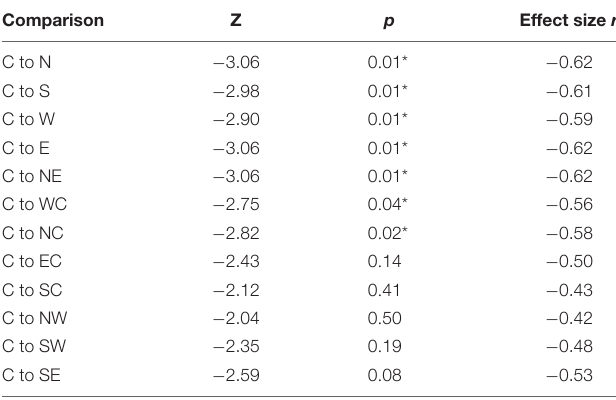
TABLE 2 | Two-tailed Wilcoxon signed rank tests between MEP interpeak amplitudes at the hot spot (C) and the other 12 stimulation conditions.